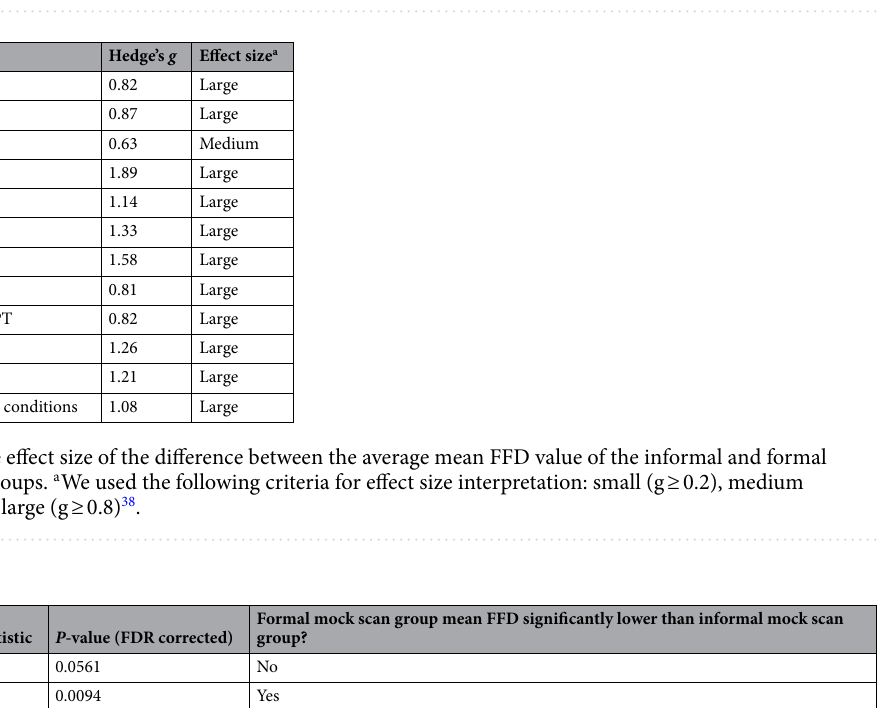
Figure 2. Low-motion data can be obtained in the formal mock scan group across different scan conditions. For all plots ( a – c ), the scan condition is shown below the x-axis; the mean FFD (mm) is shown on the y-axis. The average mean FFD for each group/condition is shown as a bar; error bars correspond to standard error of the mean. ( a ): mean FFD values for gradCPT and rest scans. ( b ): mean FFD values for the movie scans. ( c ): the average mean FFD value for each condition. The grand mean FFD over all eight functional scans is shown to the right of the plot and is referred to as “Average” under the x-axis ( FFD frame-to-frame displacement; mm millimeters).